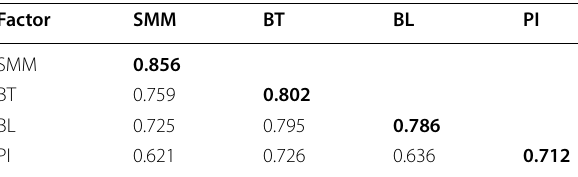
Table 3 Results of measurement model: discriminant validity- HTMT criteria Source : Primary Data